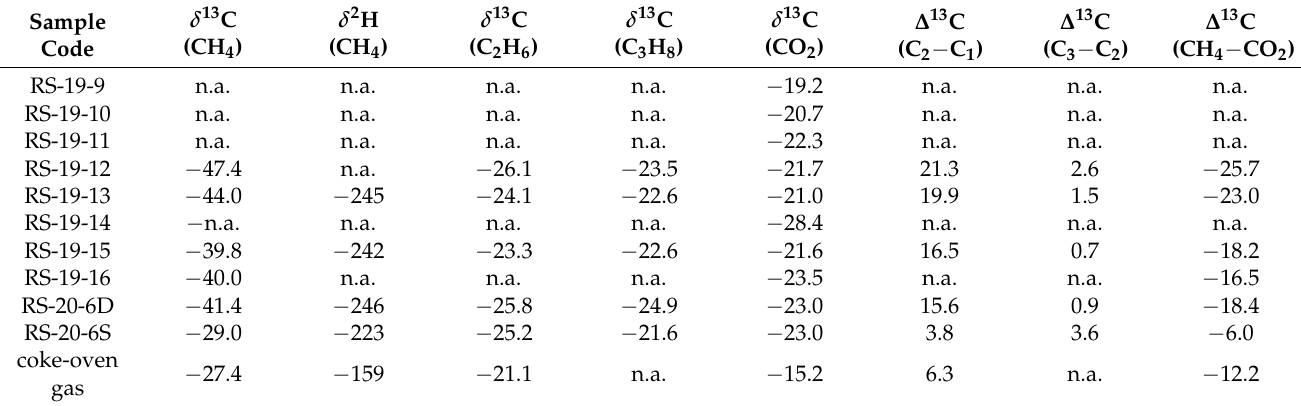
Table 3. Stable isotope composition and indices (‰) of gases collected from Rymer waste